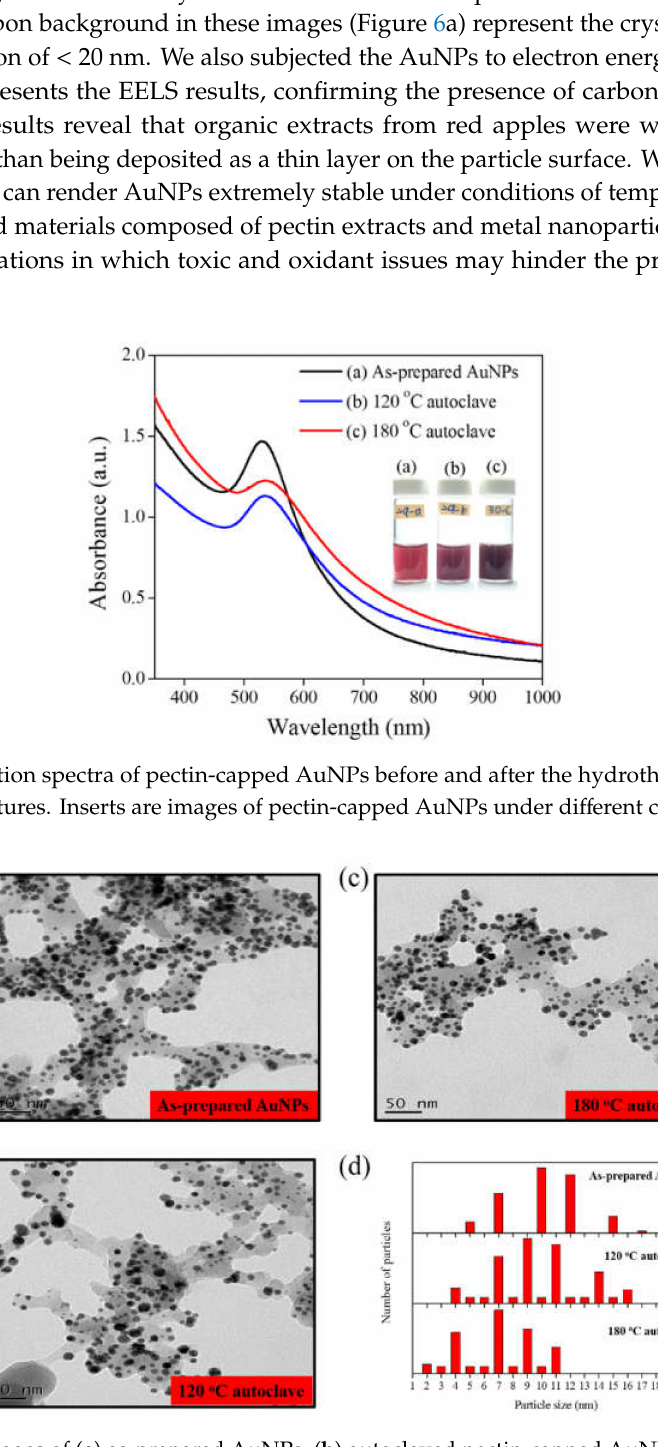
Figure 5. TEM images of ( a ) as-prepared AuNPs; ( b ) autoclaved pectin-capped AuNPs at 120 ◦ C, and ( c ) autoclaved pectin-capped AuNPs at 180 ◦ C; ( d ) Particle size distribution of as-prepared AuNPs, and pectin-capped AuNPs under hydrothermal process at di ff erent